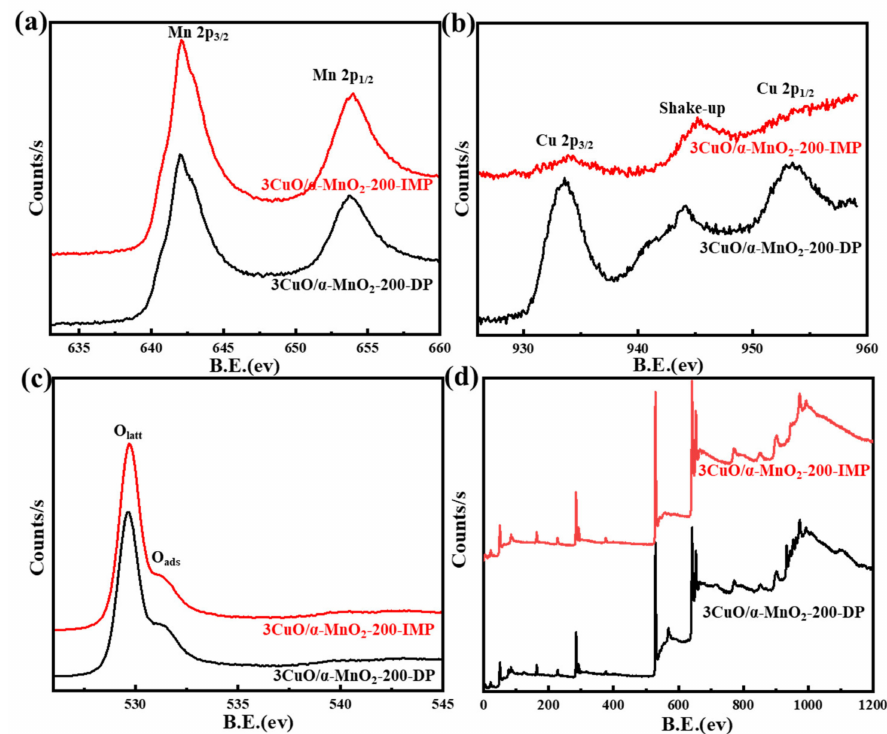
Figure 4. XPS spectra of Mn 2p ( a ), Cu 2p ( b ) , O 1s ( c ) and survey spectrum ( d ) for 3CuO/ α -MnO 2 -